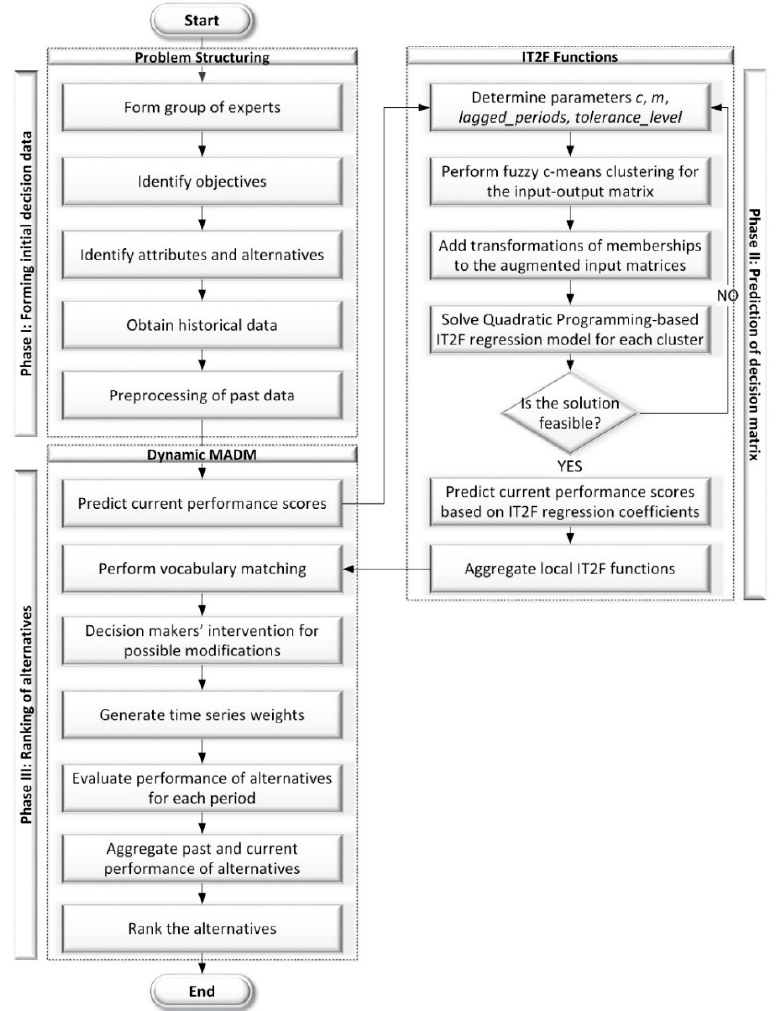
Figure 2. Flowchart of the proposed